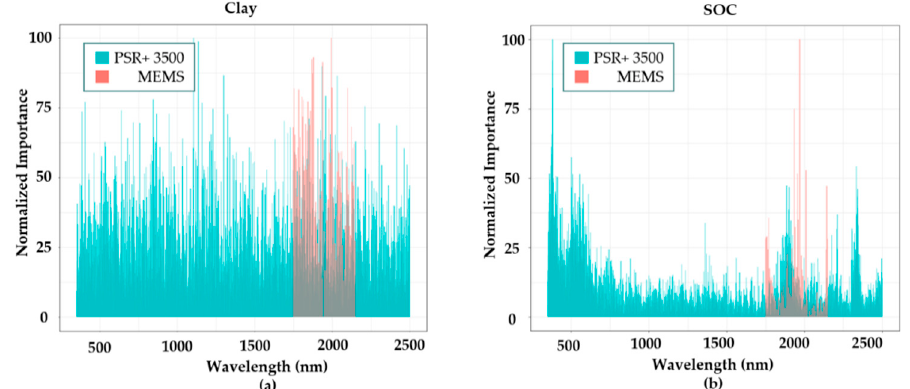
Figure 8. Normalized variable importance scores for each wavelength based on RF modeling. ( a ) Clay; ( b ) SOC. Despite that, the lower accuracy of the MEMS sensors compared to the PSR+ 3500 is presumable due to the smaller spectral range and spectral resolution and hence missing spe- cific wavelengths that could enhance model’s predictive performance. As it is shown from various studies mentioned above, both the visible spectral region and wavelengths above 2200 nm can hold additional valuable information that could result in better prediction